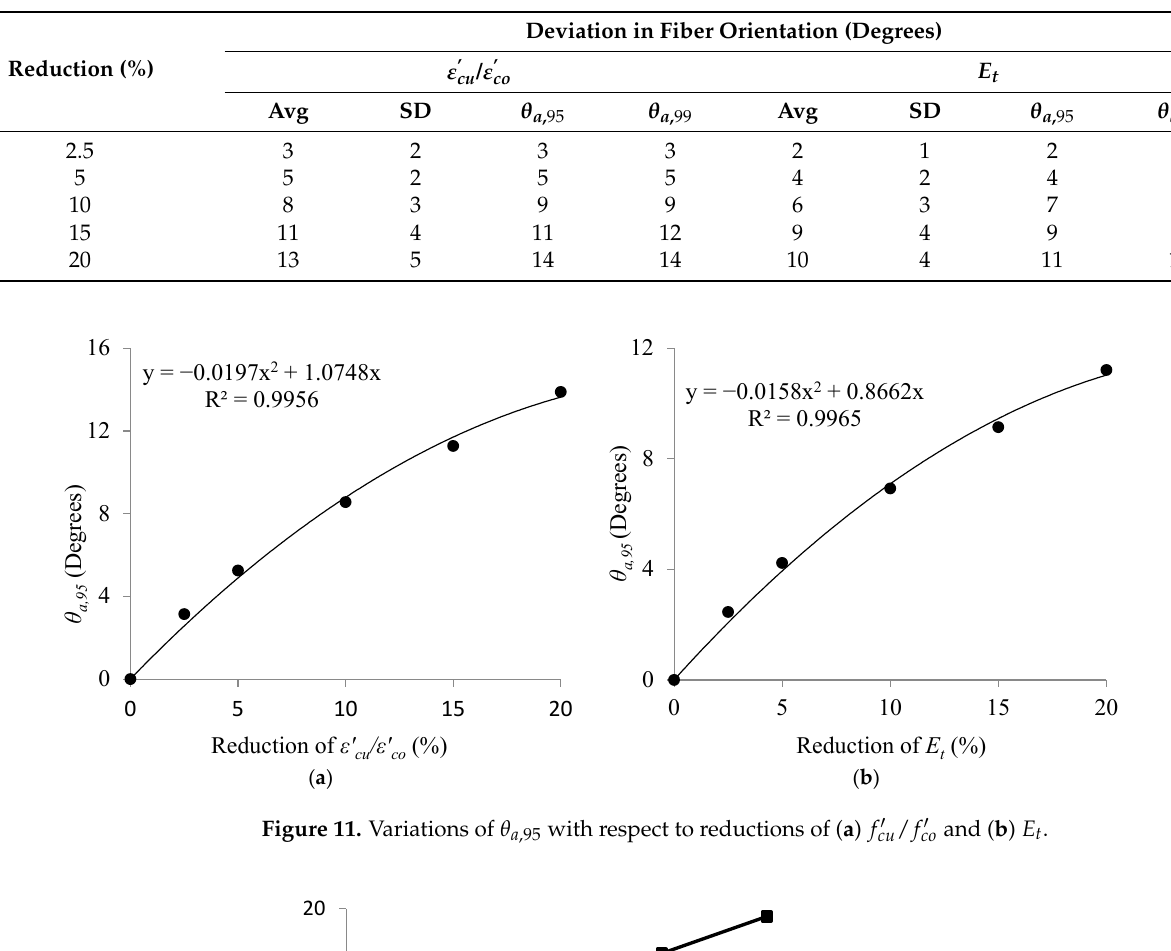
Table 13. Fiber orientations for different reductions in 𝜀 (cid:3030)(cid:3048)(cid:4593) /𝜀 (cid:3030)(cid:3042)(cid:4593) and 𝐸 (cid:3047) .